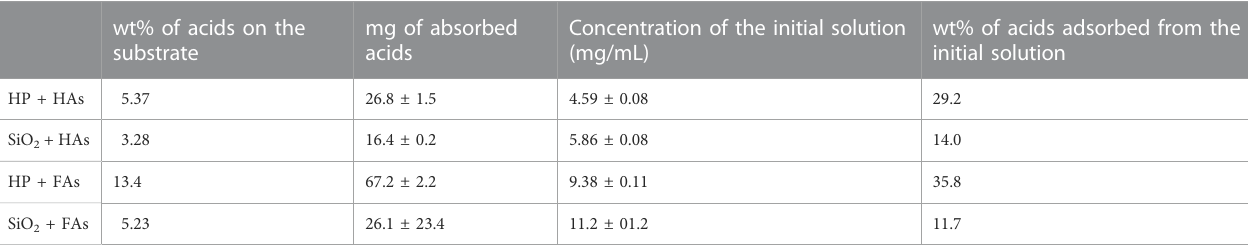
TABLE 1 Amount of HAs and FAs adsorbed on inorganic matrixes. wt% of acids on the substrate